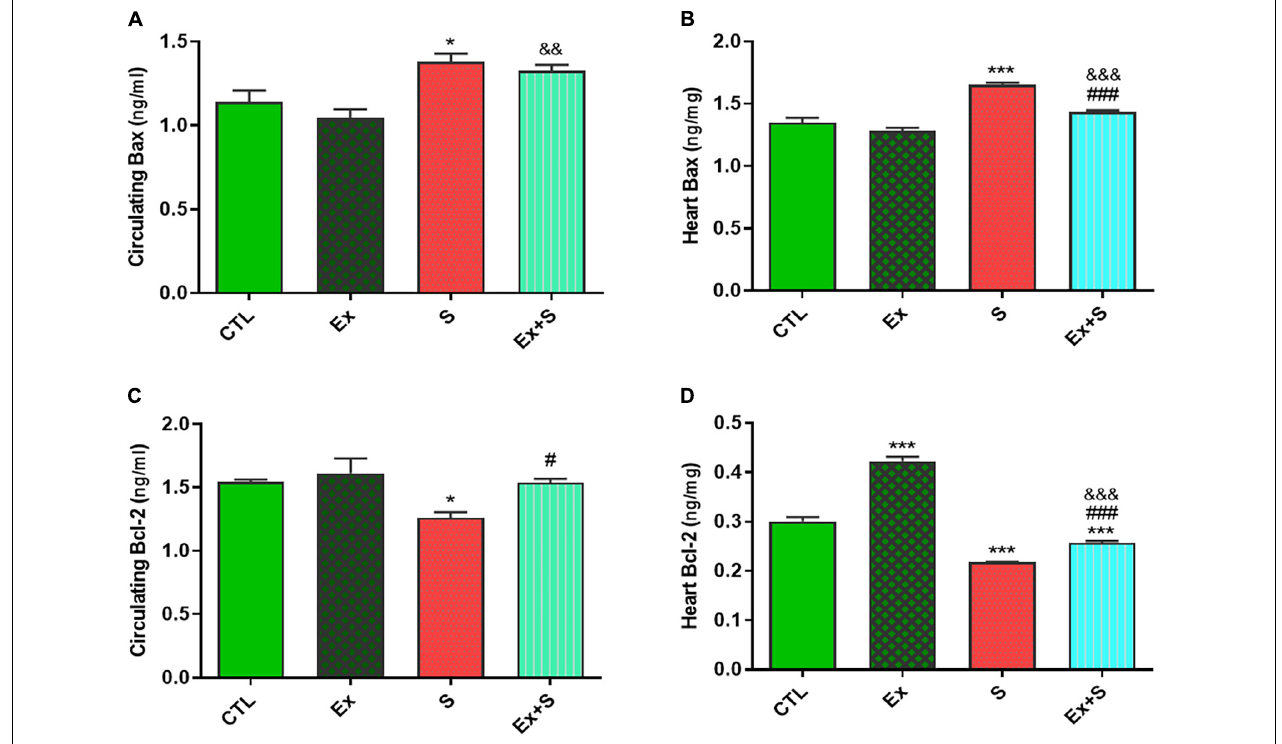
FIGURE 7 | Effects of waterpipe smoke inhalation on Bax levels in serum (A) and in the heart (B) , and Bcl-2 levels in serum (C) and in the heart (D) in experimental groups. CTL, control group; Ex, group subjected to exercise training for 8 weeks; S, group subjected to waterpipe tobacco smoke inhalation for 8 weeks; Ex + S, group subjected to exercise training and waterpipe tobacco smoke inhalation for 8 weeks. The results are presented as mean ± SEM, n = (6–7). * P < 0.05, *** P < 0.001 vs. CTL; # P < 0.05, ### P < 0.001 vs. S; && P < 0.01, &&& P < 0.001 vs. Ex.